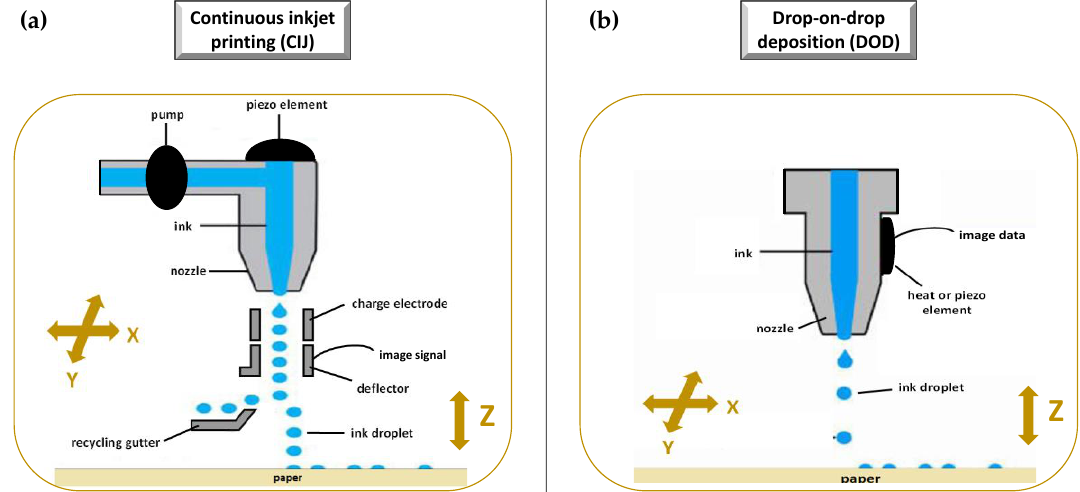
Figure 8. Ink-jet based printing technology ( a ) Continuous (CIJ), ( b ) drop-on-demand (DoD). Drop-on-Solid (DOS)